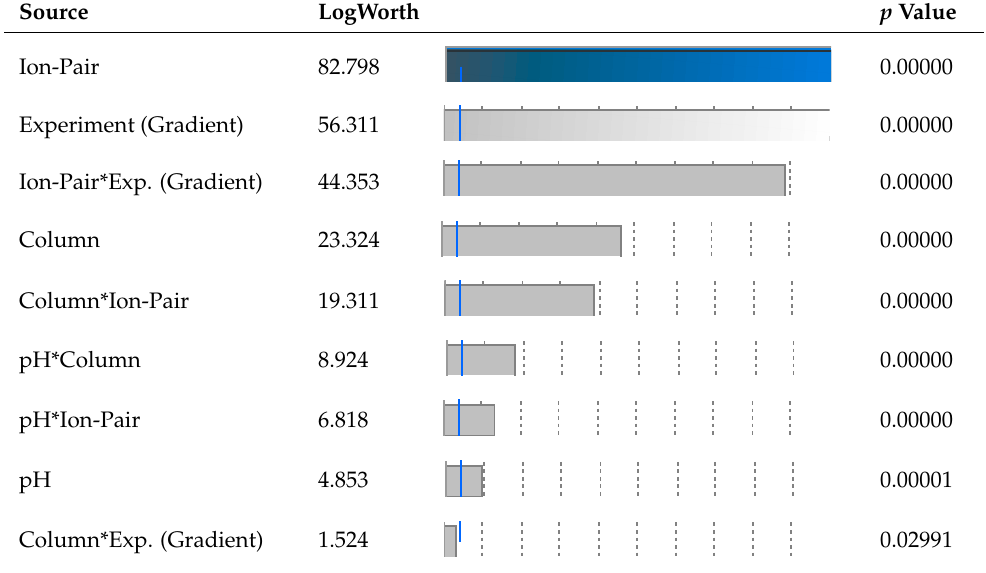
Table 3. Effect summary for the whole model using a factorial standard least square method up the 2nd degree with only significant terms.